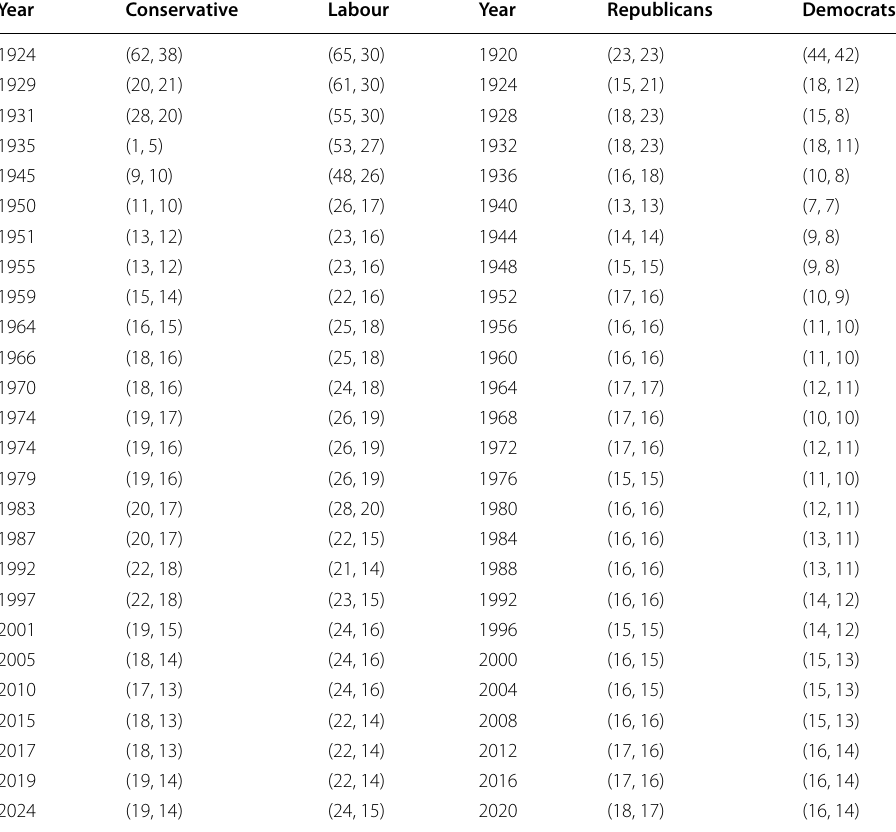
Left: United Kingdom. Right: United